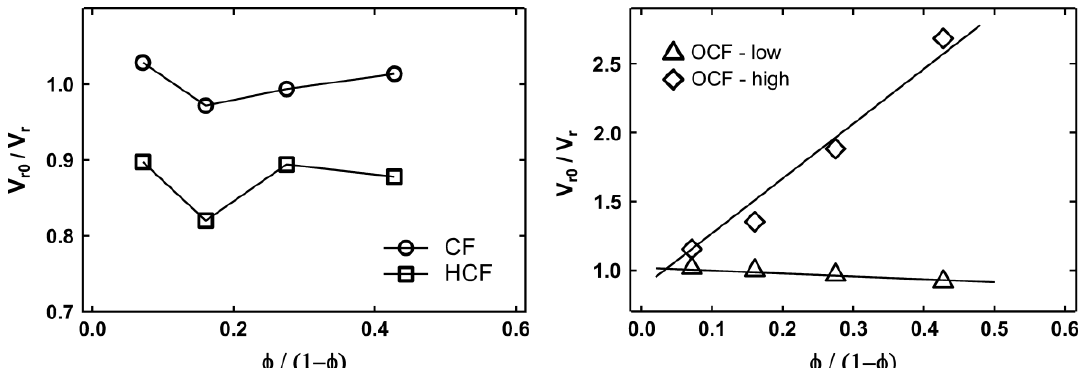
Figure 7. Kraus plot for corn flour (CF), hydrolyzed corn flour (HCF), oxidation corn flour-low oxidation level (OCF-low) and oxidation corn flour-high oxidation level (OCF-high) [63].